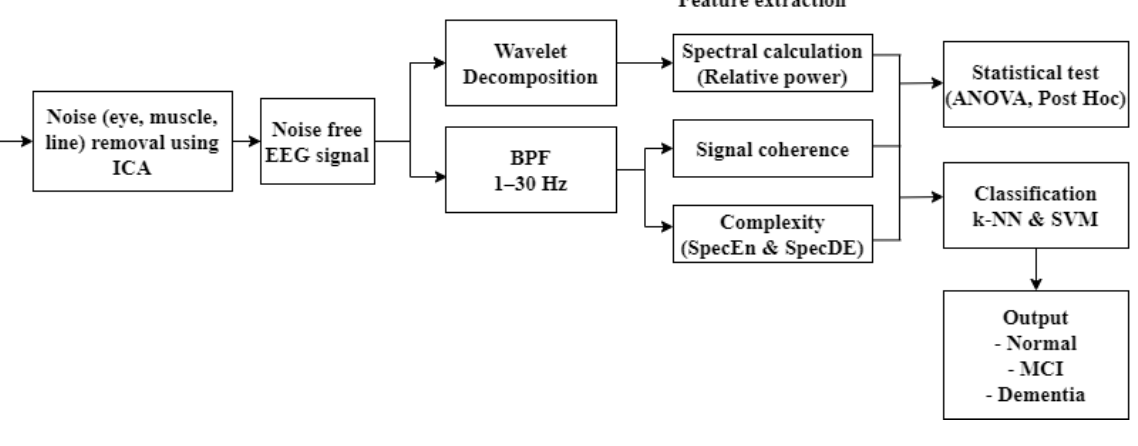
Figure 1. Classification design.